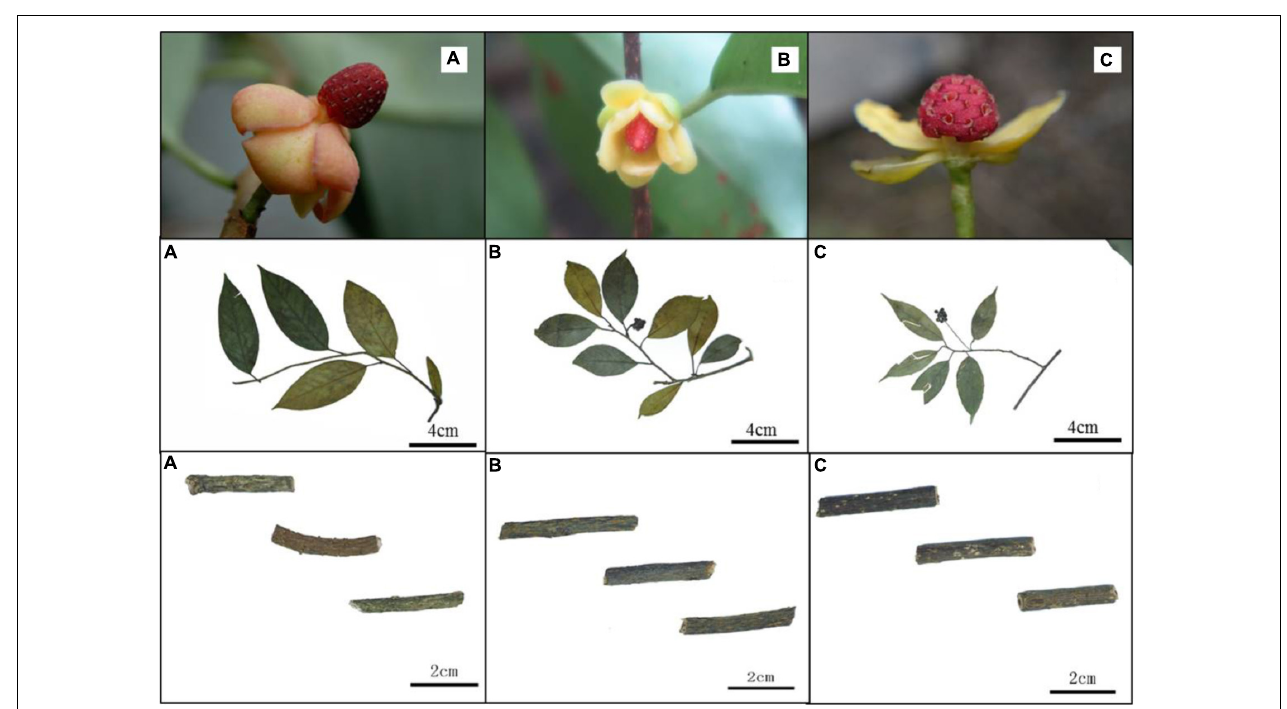
FIGURE 1 | Morphology of K. coccinea (A) , K. heteroclita (B) and K. longipedunculata (C) .